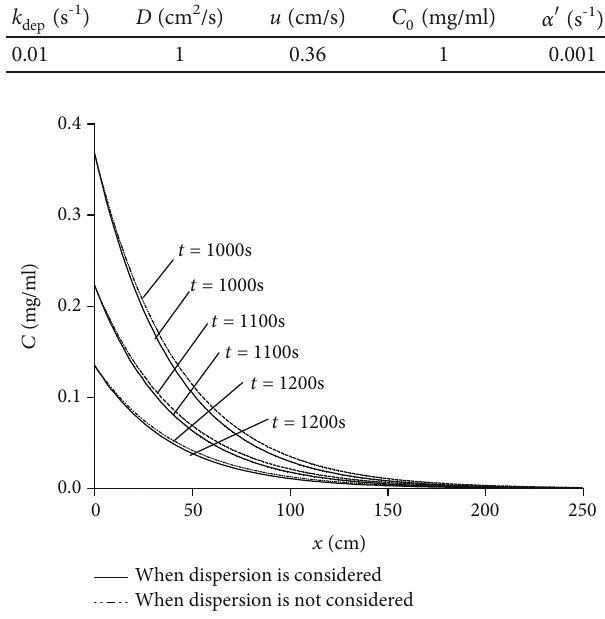
Figure 2: Relationship between particle concentration and distance for various times predicted by equations (18) (solid curves) and (19) (dashed curves), using parameters given in Table